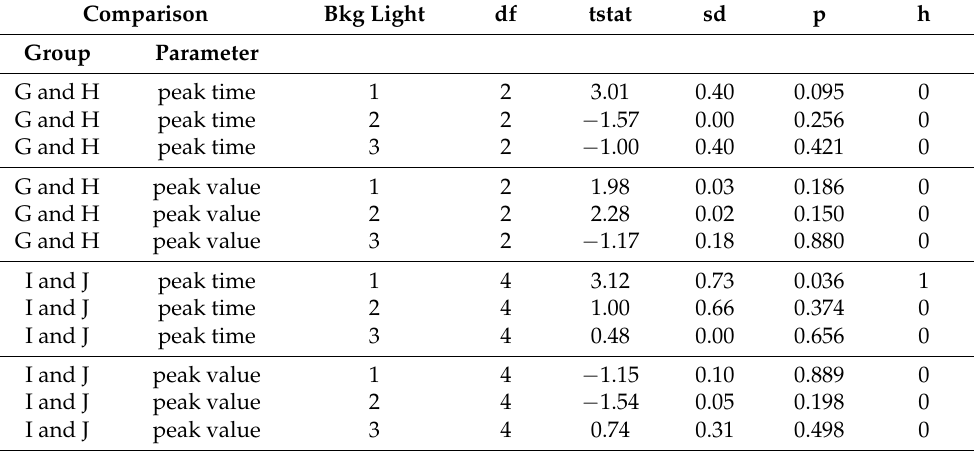
Table A2. Two way ANOVA table, comparing peak times and peak values for healthy (Ref)